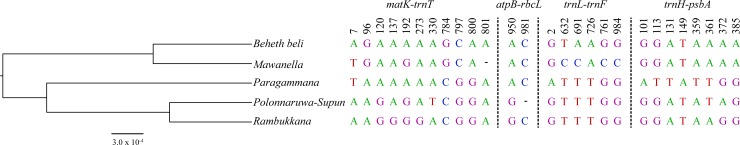
The hierarchical clustering of the accessions of A. marmelos using combined sequence datasets.The unweighted pair group method with arithmetic mean (UPGMA) tree is given in the left. The scale bar represents the uncorrected pairwise distance. The associated SNP and INDEL positions for matK-trnT, atpB-rbcL, trnL-trnF and trnH-psbA intergenic spacers and their positions are given next to the UPGMA tree.